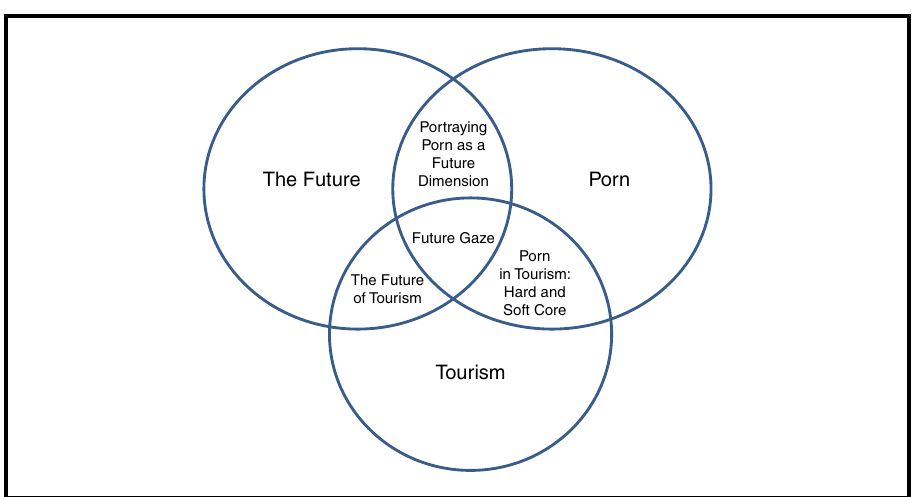
Figure 1 The future of porn and travel: consumption and gaze